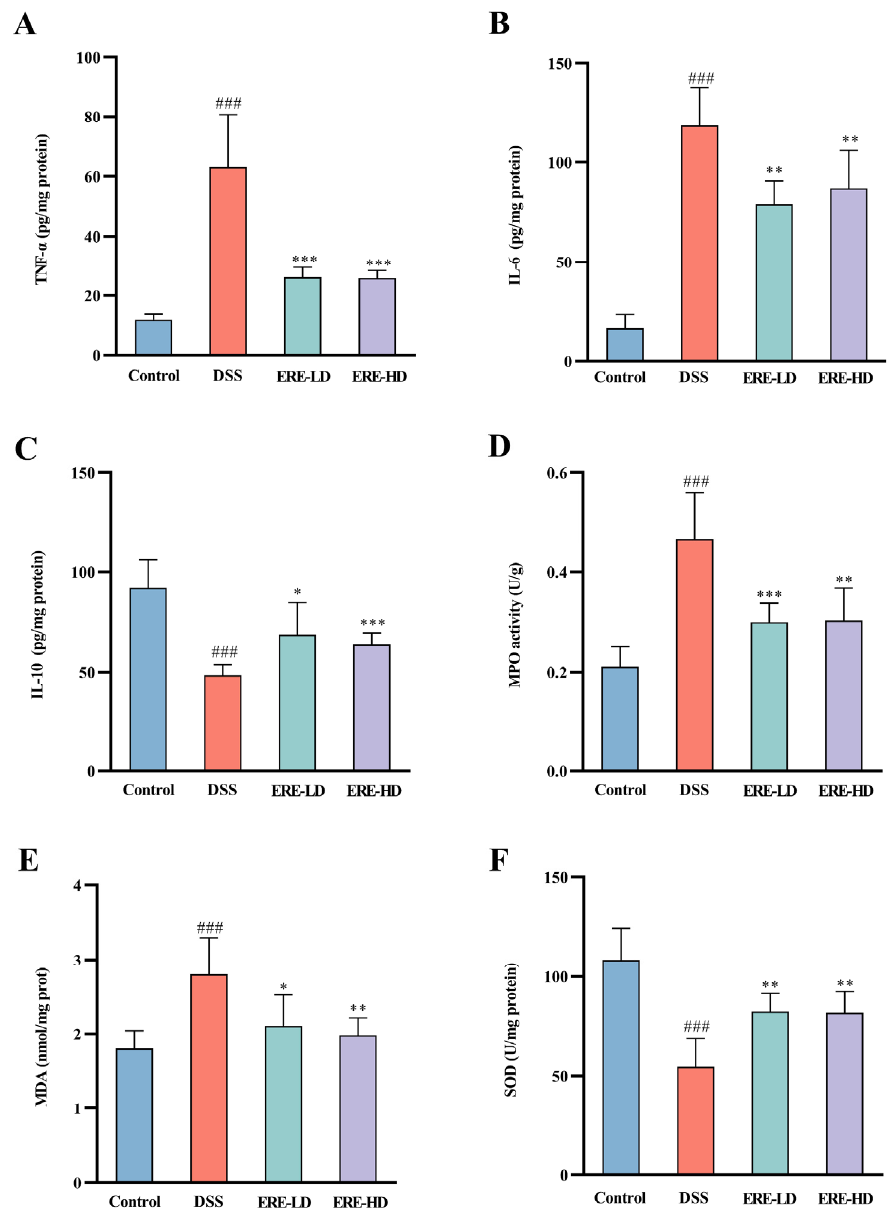
Figure 8. Effects of ERE on inflammatory cytokines and the activity of enzymes in the colon. The cytokine levels of TNF- α , IL-6 and IL-10 among different groups ( A – C ). The myeloperoxidase (MPO) activity ( D ), malondialdehyde (MDA) levels ( E ) and superoxide dismutase (SOD) activity ( F ) in the colon tissues from different groups. The values are expressed as the mean ± S.D: * p < 0.05 compared with DSS group; ** p < 0.01 compared with DSS group; *** p < 0.001 compared with DSS group; ### p < 0.001 compared with control group.